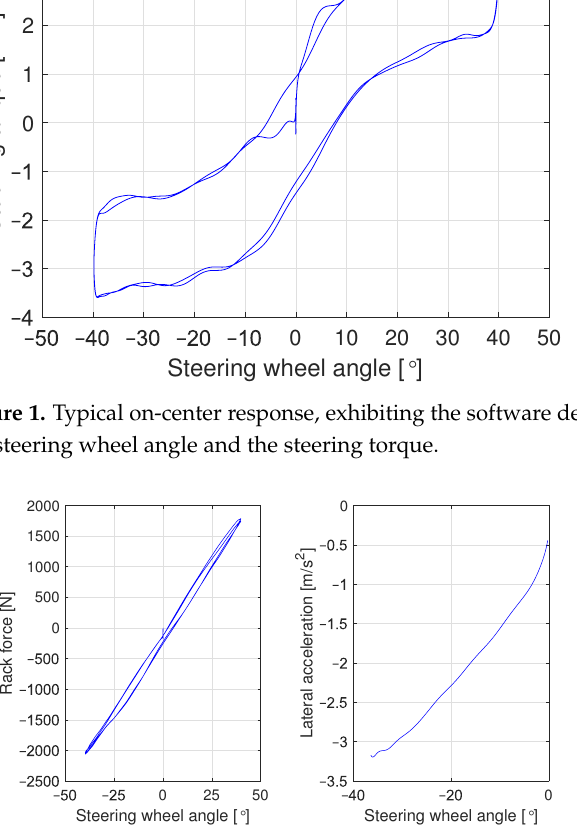
Figure 2. A linear relation between the steering wheel angle and the steering rack force as well as the lateral